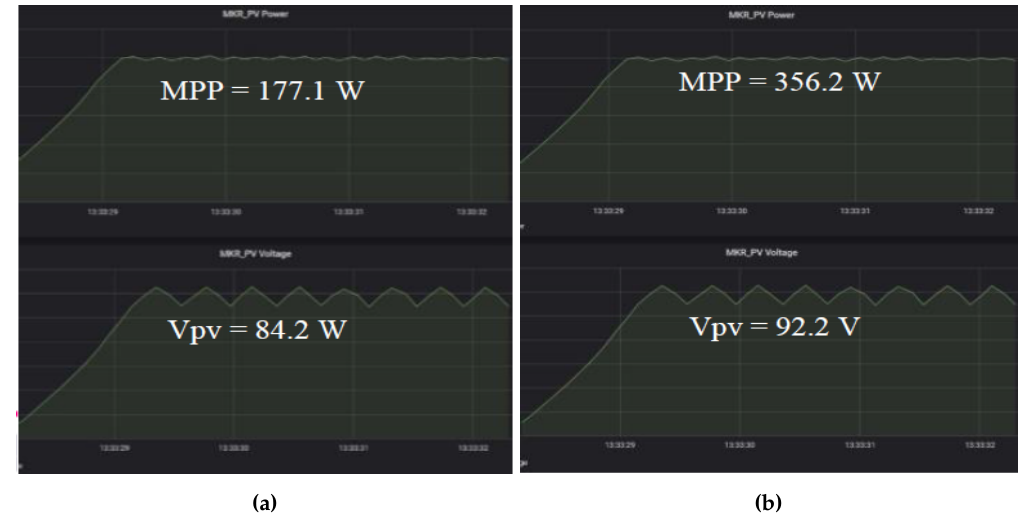
Figure 10. Data visualization on Grafana : ( a ) 334 W/m 2 setting; and ( b ) 667 W/m 2